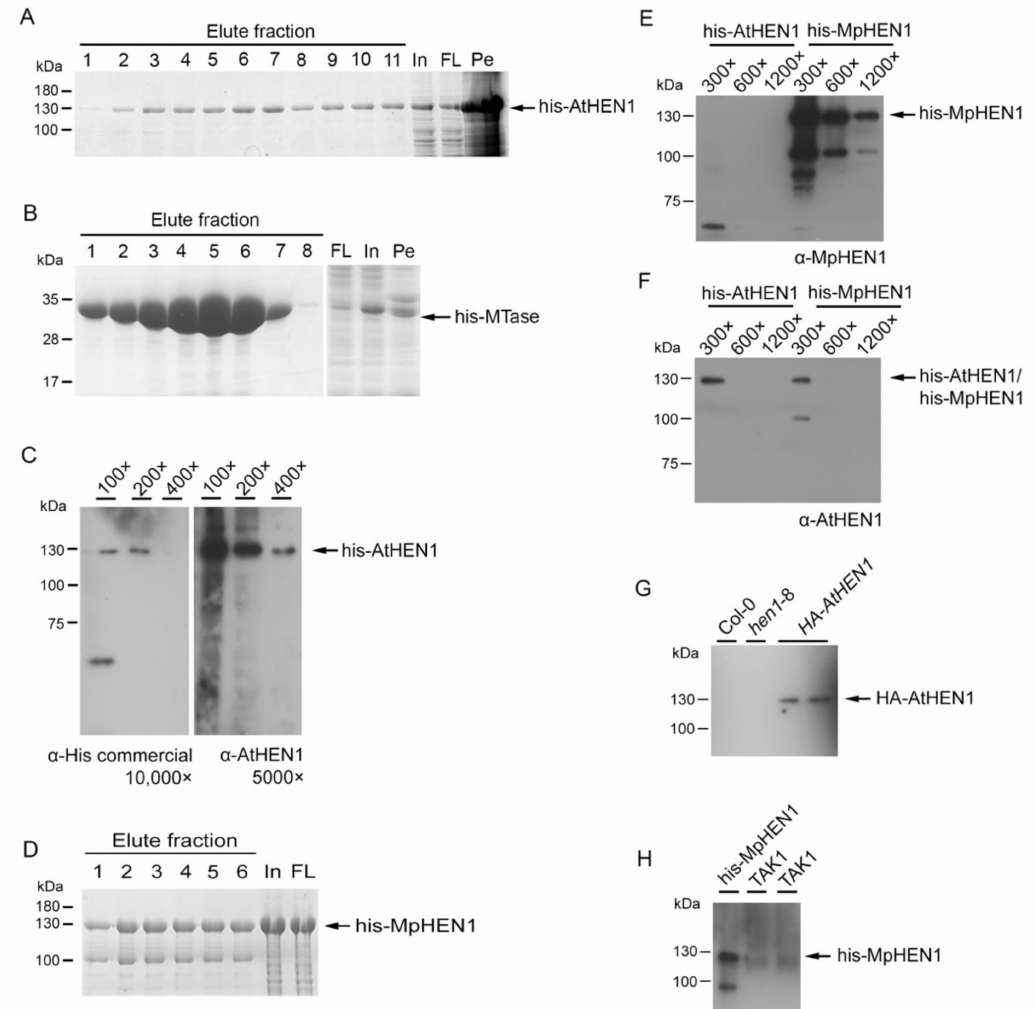
Figure 1. α -AtHEN1 and α -MpHEN1 antibodies production and sensitivity analysis. ( A ) The SDS-PAGE analysis for the eluted fractions of the recombinant full-length his-AtHEN1. The band corresponding to 130 kDa showed the presence of the expected protein. ( B ) SDS-PAGE analysis for the eluted his-MTase. The prominent band at 34 kDa depicted its expression. ( C ) The sensitivity evaluation of α -AtHEN1 (5000 × dilution) that compared with his-monoclonal antibody (10,000 × dilution). ( D ) The SDS-PAGE analysis for the eluted fraction of the recombinant full-length his-MpHEN1. In, input. FL, flow-through, Pe, pellet. The evaluation of antibody cross-reaction between α -AtHEN1 ( E ) and α -MpHEN1 ( F ) antibodies at different dilutions of his-AtHEN1 and his-MpHEN1. Both antibodies were diluted at 10,000 × . ( G ) The endogenous AtHEN1 detection for α -AtHEN1 antibody. WT, Col-0. hen1-8 , the HEN1 mutant. HA-AtHEN1 , the HA-AtHEN1 plant. ( H ) The endogenous MpHEN1 detection for α -MpHEN1 antibody. His-MpHEN1, the recombinant MpHEN1. TAK1, the WT of male M. polyporpha